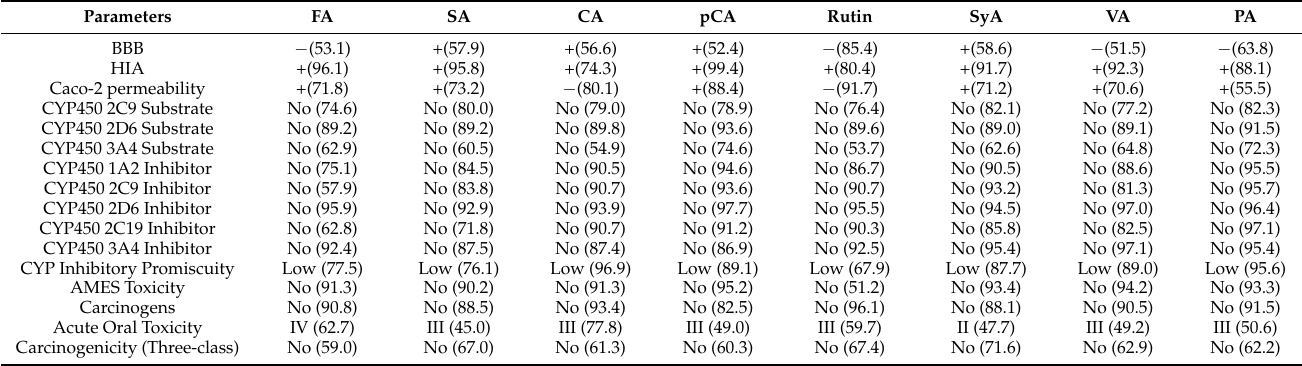
Table 4. ADMET properties of the selected isolated